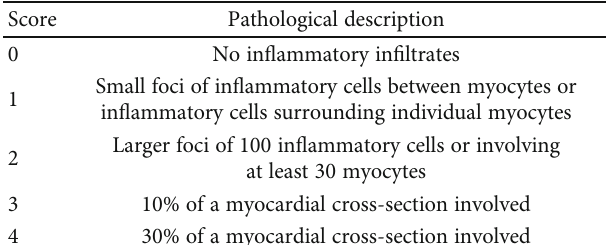
Table 4: Pathology semiquantitative scale.